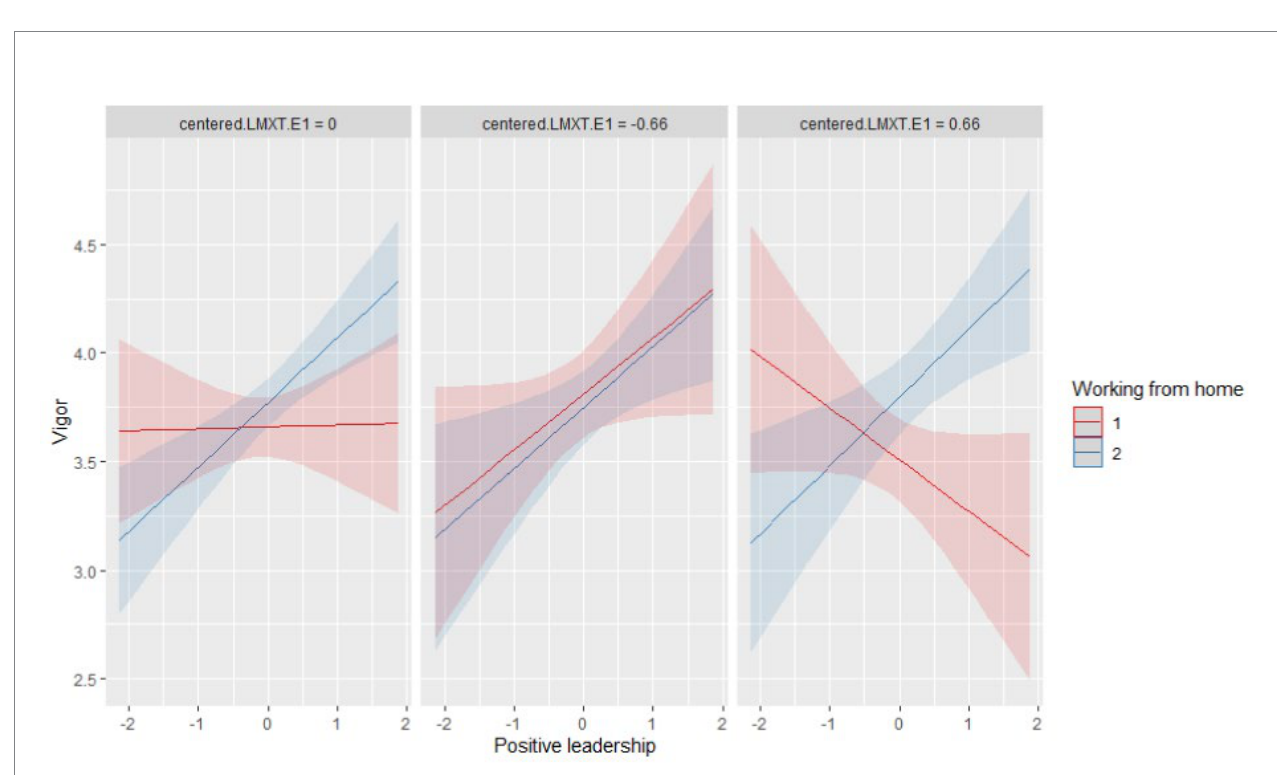
FIGURE 2 Three-way interaction (positive leadership × working from home × leader-follower relationship tenure) on the relationship between positive leadership behaviors and vigor. LMXT.E1 denotes leader-follower relationship tenure; Working from home “yes” is coded “1,” “no” is coded